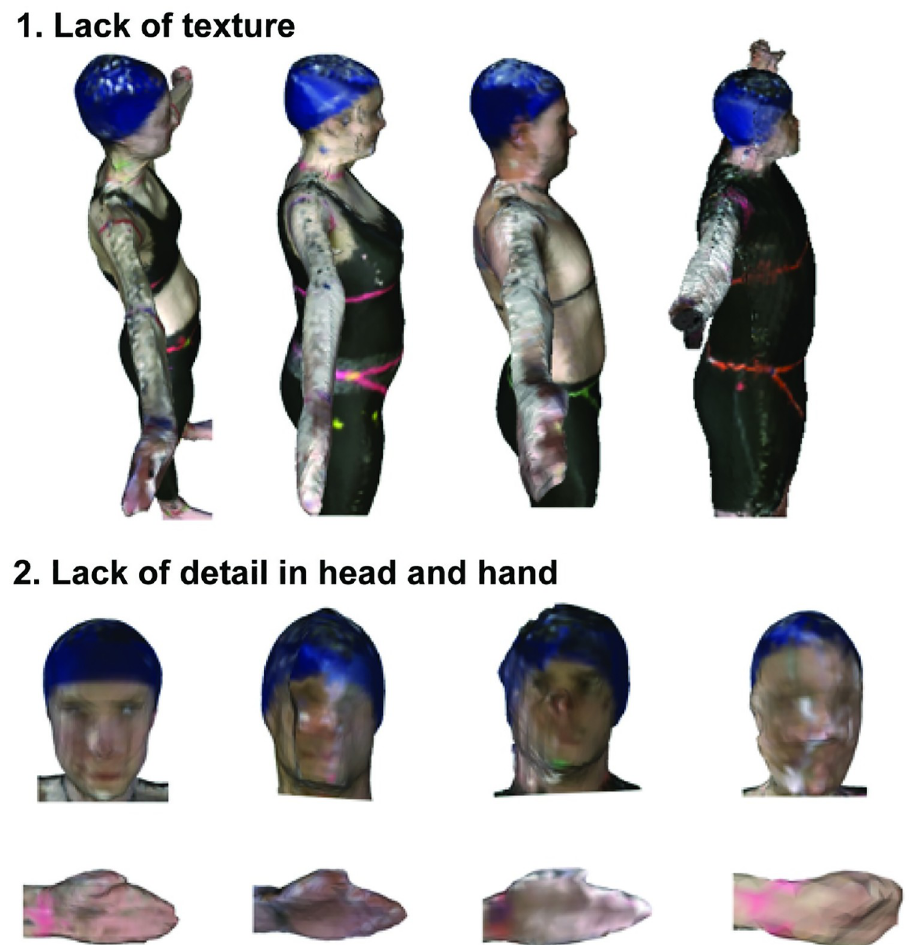
Fig 8. Top view of full-body, head and hand scans. 1. An example showing lack of texture in the scan on the upper arm regions. 2. Varied degree of detail in the head region with concave surfaces appears as filled in. Further to the right head suggests minor sway, as facial features are distorted more so than the head to the left. Hands showing varied degree of detail. depth perception is in the 0.5-2m range away from the participant, where the camera has depth perception errors of less than 2mm [56]. Scanning distances of less than 0.5m away, which would be the case for participants who had an arm’s length of more than 0.5m, enter a suboptimal and more error-prone field of view [56]. 3D scanning of curved, concave, and sharp edges is also a known limitation with 3D scanning technologies. Error-prone surfaces may be smoothed out when perceiving depth [34,56]. To minimize this in our protocol, we asked participants to keep their hands open during scanning as a means of preventing concav- ity when the hands are supinated. However, visual occlusion of other concave surfaces is still evident, such as on the face (Fig 8). For females with larger breasts, the gap between the breasts may have been overestimated, especially as all female participants wore a shirt. As our approach estimated upper trunk masses about ~2kg higher for females (Table 5) when com- pared to the ECM approach, these overestimations may be partially due to sensor limitations for convex regions and gaps. Lastly, the depth perception of the device has been shown to be a function of operating time where after ~40 minutes of operating and warming up, the depth